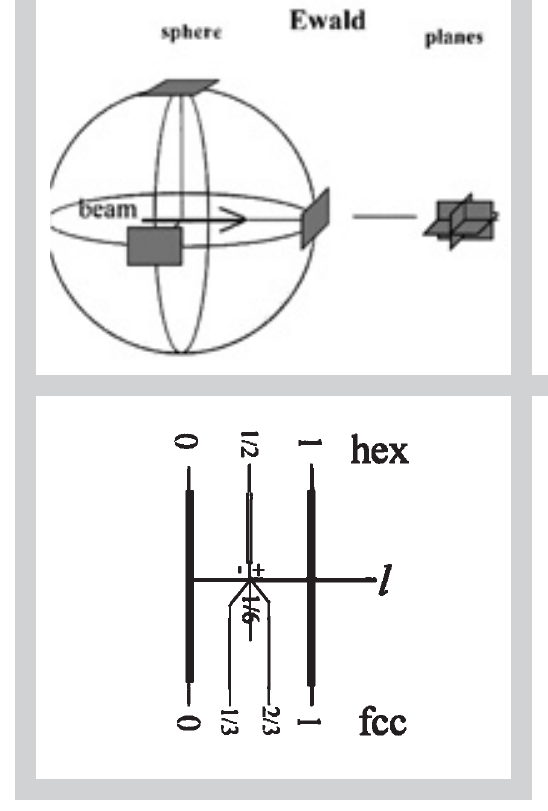
Figure 1 (left above): Ewald sphere and Ewald planes. Figure 2 (right above): h, k-layer at l=0 (h, k, l = Miller indices). Figure 3 (below): Energy diagram (l-depen- dence) for hexagonal and for cubic